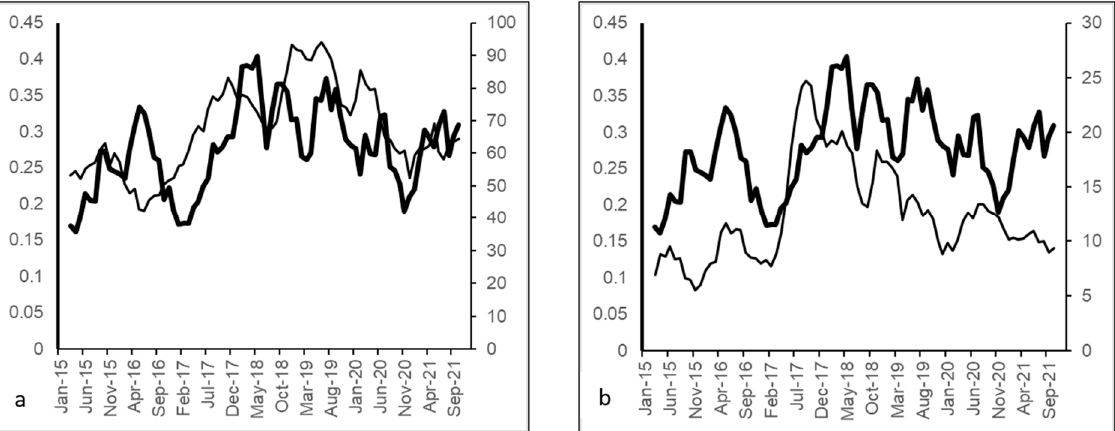
Figure 1. Monthly ESBL-producing E. coli incidence versus use of selected antibiotic classes (thick line, ESBL-producing E. coli , no. of cases/1000 OBD, 5-month moving averages, left-hand y-axis; thin line, antimicrobial use, DDD/1000 OBD, 5-month moving averages, right-hand y-axis): ( a ) fluoro- quinolones; ( b ) third-generation cephalosporins.